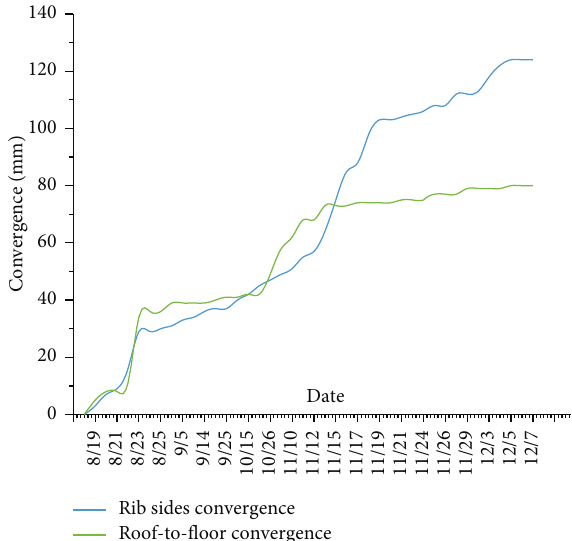
Figure 20: Convergence monitoring results of surrounding rock deformation at station #2. Figure 21: Displacement monitoring results of surrounding rock deformation at station